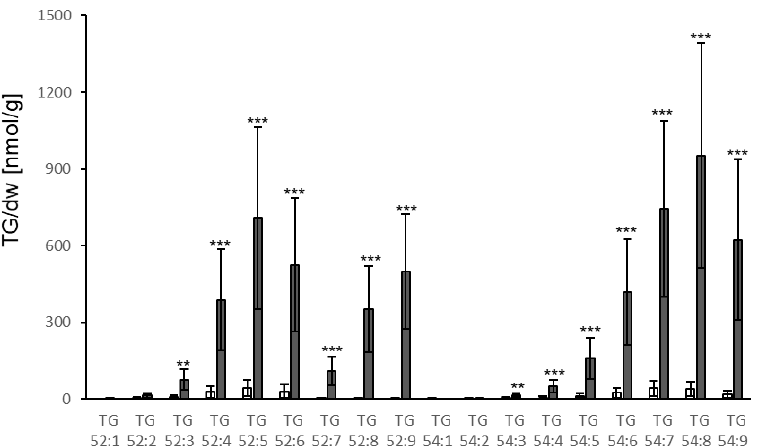
Figure 8. Accumulation of different TG species in leaves of Dex::avrRPM1 plants 24 h after spraying of leaves with dexamethasone to induce expression of AVRRPMI (Dex, dark grey bars) or mock (white bars). TG species are characterized by their total number of acyl carbons and the number of double bonds. TG levels [nmol/g dry weight] shown represent the mean of at least four biological replicates ± sd. Asterisks indicate significant differences between the dexamethasone treated samples and the corresponding mock treated sample (** p < 0.01; *** p < 0.001).